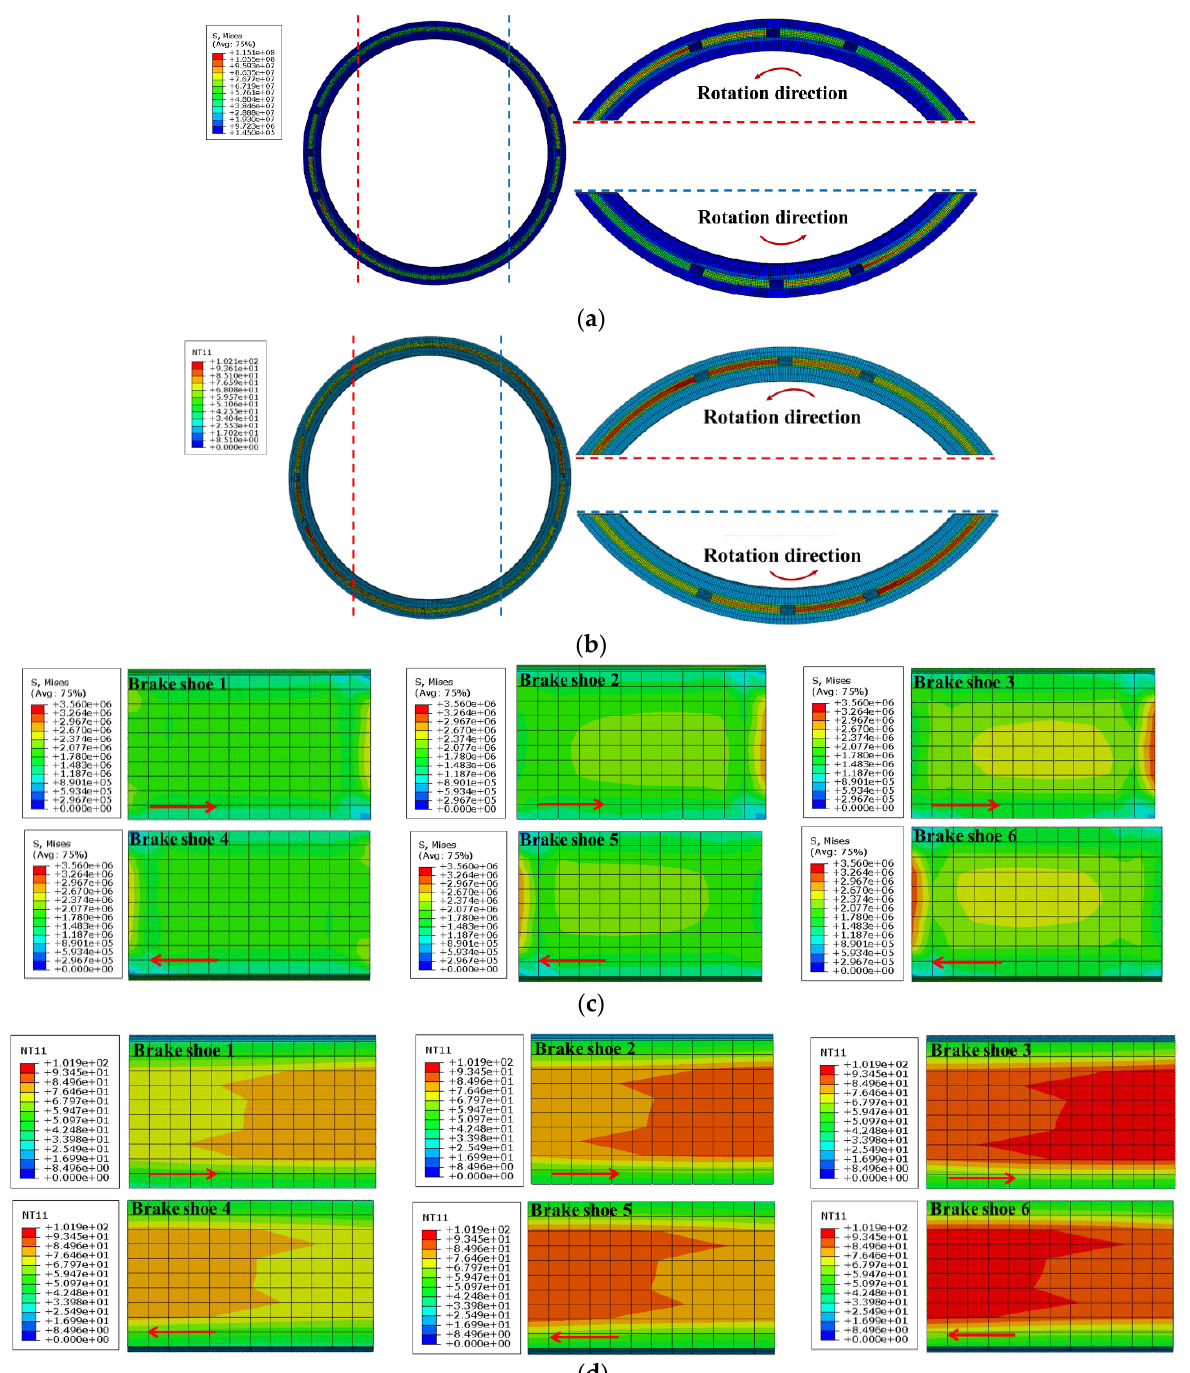
Figure 11. Distributions of equivalent stresses and temperature of the brake disc and the brake shoe at the typical moment of 4.38 s during emergency braking (the red arrow represents the sliding direction of the brake disc). ( a ) Distributions of equivalent Von Mises stresses of the brake disc and the brake shoe. ( b ) Distributions of temperature fields of the brake disc and the brake shoe. ( c ) Distributions of equivalent stresses of the contact surfaces of brake shoes 1-6. ( d ) Distributions of temperature fields of the contact surfaces of brake shoes 1-6. (Note: in the figures, e+02 is equivalent to × 10 2 for example)